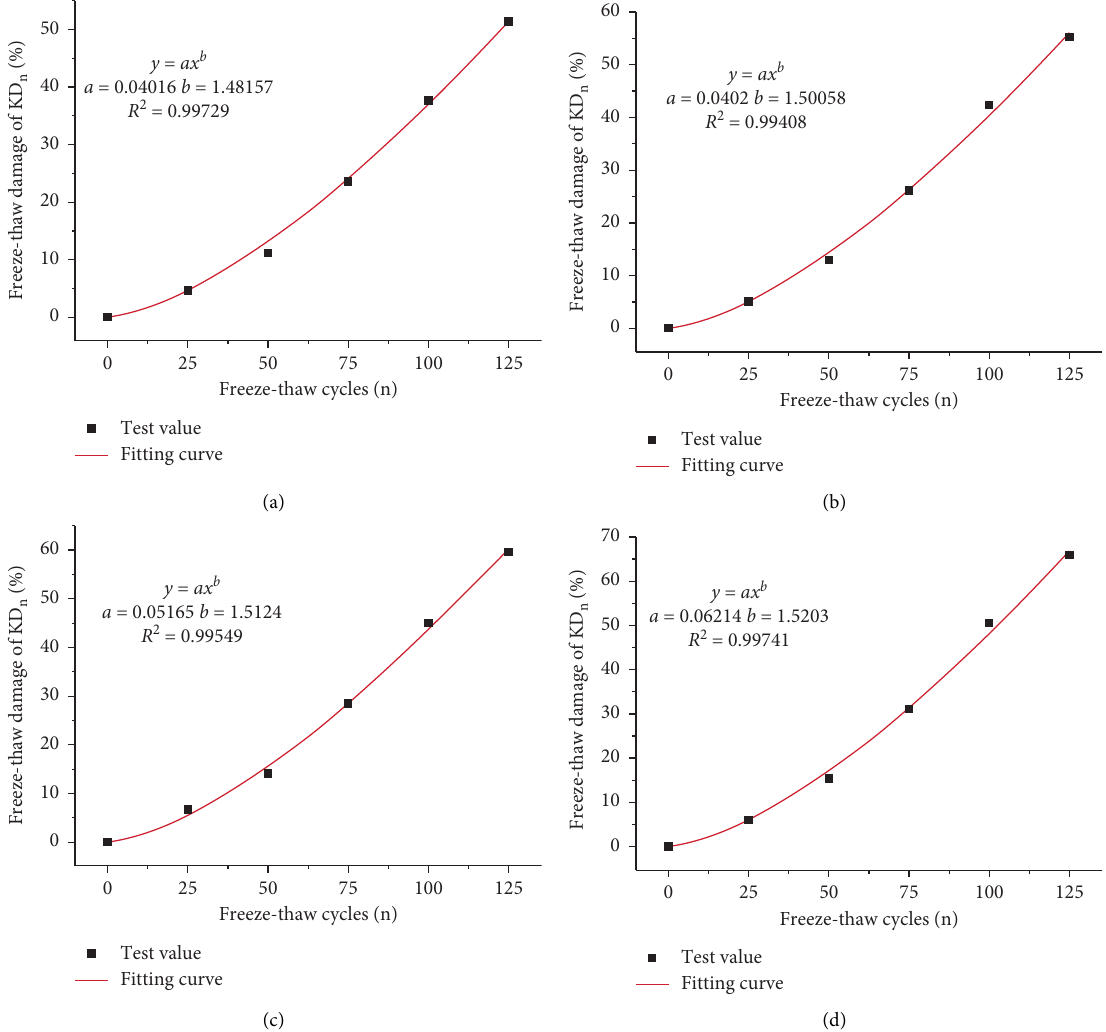
Figure 10: Freeze-thaw damage of fracture toughness of gangue concrete with different replacement rate. (a) Replacement rate of 0%. (b) Replacement rate of 40%. (c) Replacement rate of 70%. (d) Replacement rate of